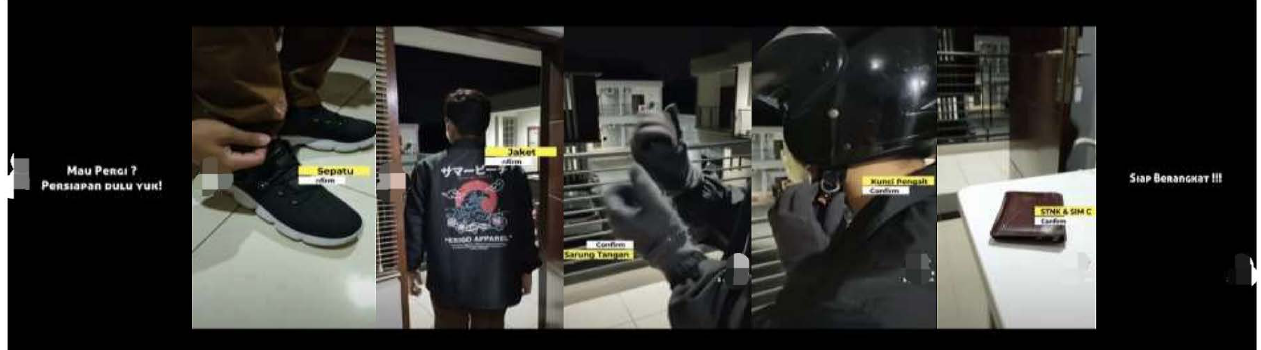
Figure 1. Capture of TikTok video in the Zainafree’s RSE